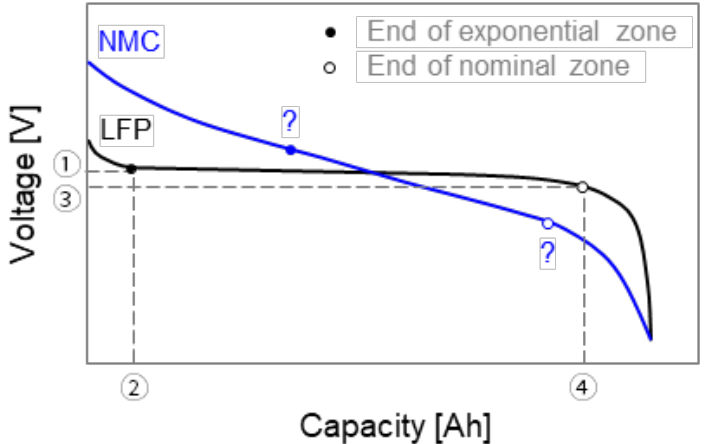
Figure 5. Circuit schematic for battery model. Figure 6. Comparison of NMC and LFP batteries in terms of extracting key parameters from the polarization curve. (1, 2) Exponential zone (V, Ah), (3) nominal voltage (V), and (4) capacity at nominal voltage (Ah).